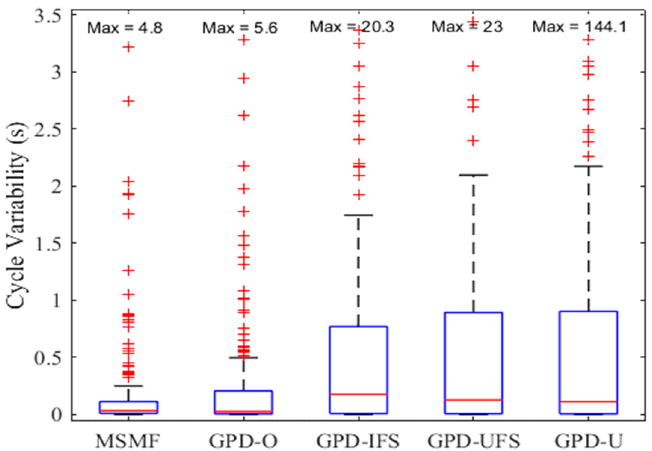
Figure 8. Stride variability changes with change in threshold value.